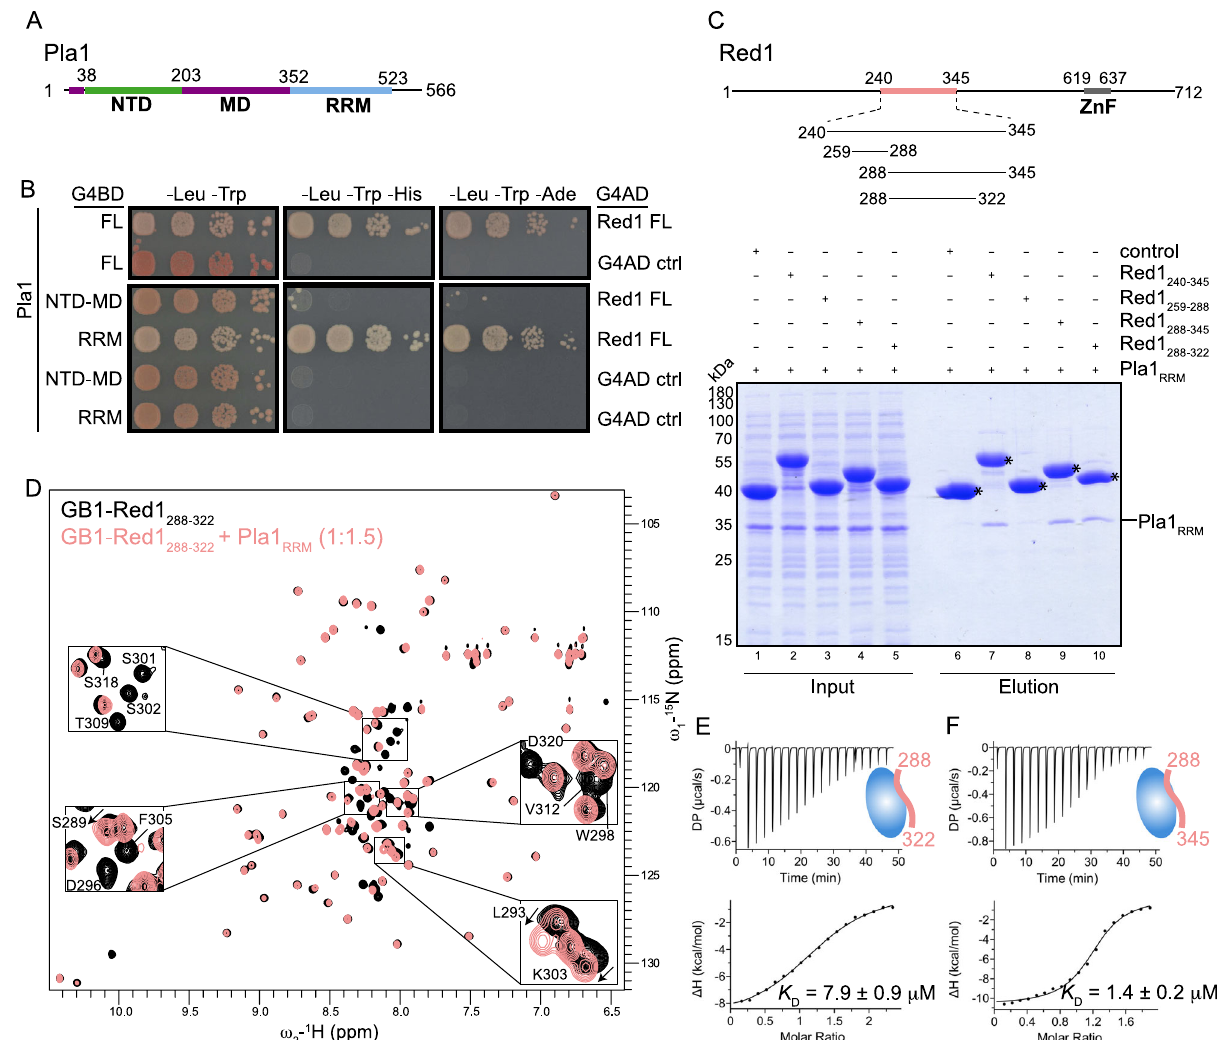
Fig. 1 | Interaction mapping between Pla1 and Red1. A Domain organisation of Pla1,consistingoftheNTD,MDandRRMdomainsshowningreen,purpleandblue, respectively. B Y2H experiments show thatthe Pla1 RRM domain isresponsible for the interaction with Red1. Full-length (FL) Pla1, Pla1 NTD-MD or Pla1 RRM constructs were fused to the Gal4 DNA binding domain (G4BD) while full-length Red1 was fused to the Gal4 activation domain (G4AD). Auto-activation controls (ctrl) for FL- Pla1 Pla1 NTD-MD and Pla1 RRM are provided. Serial dilutions of equivalent amounts of yeast were plated on double (-Leu-Trp) and triple dropout media (-Leu-Trp-His, -Leu-Trp-Ade), with growth on triple dropout media indicating an interaction betweenthetested proteins. C Invitropull-downassays.Untagged Pla1 RRM wasco-